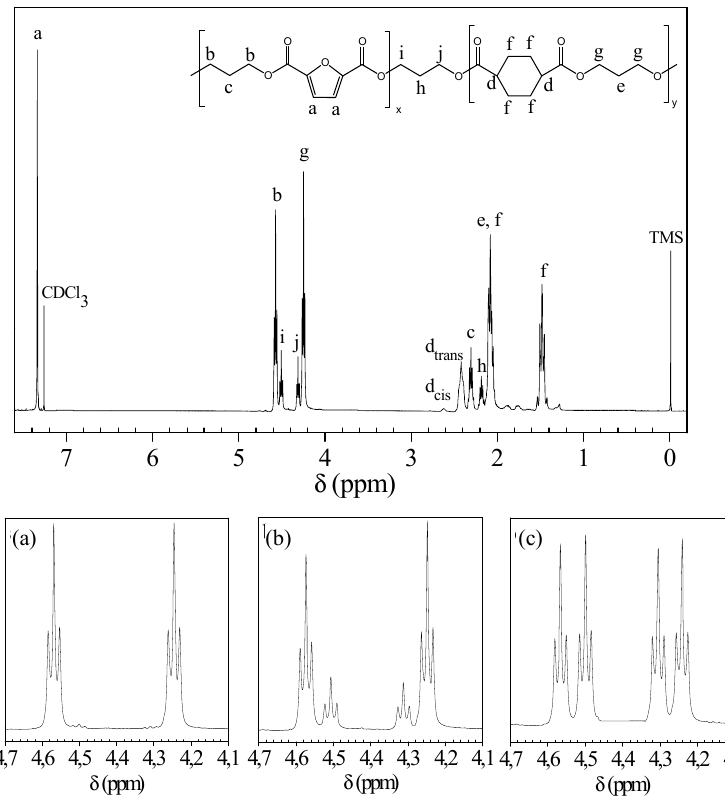
Figure 2. Top: 1 H-NMR spectra of PPFPPCE-40 with resonance assignments; Bottom: Enlargement of 1 H-NMR spectra in the region of 4.1–4.7 ppm. Evolution of the spectrum as a function of the mixing time: (a) PPFPPCE-5; (b) PPFPPCE-25; (c) PPFPPCE-90.